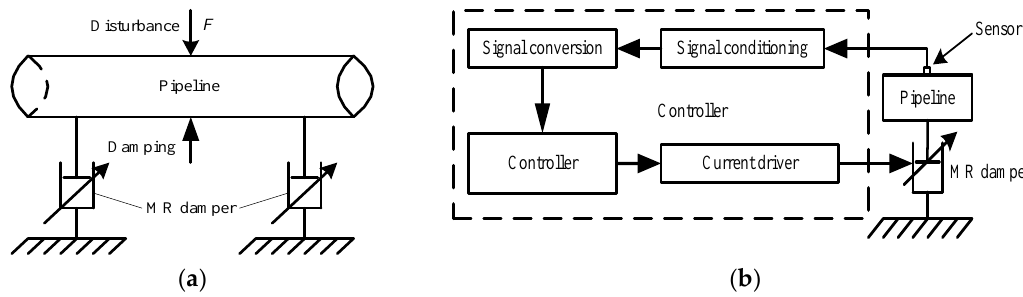
Figure 1. Schematic diagram of pipeline vibration control system based on a magneto-rheological (MR) damper: ( a ) Structural diagram; ( b ) Control block diagram